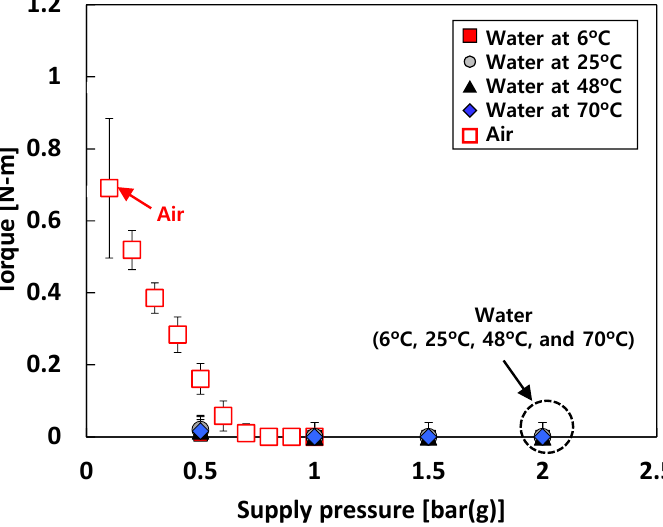
Figure 9. Test cases #1 and #2: measured bearing torque versus supply pressure.